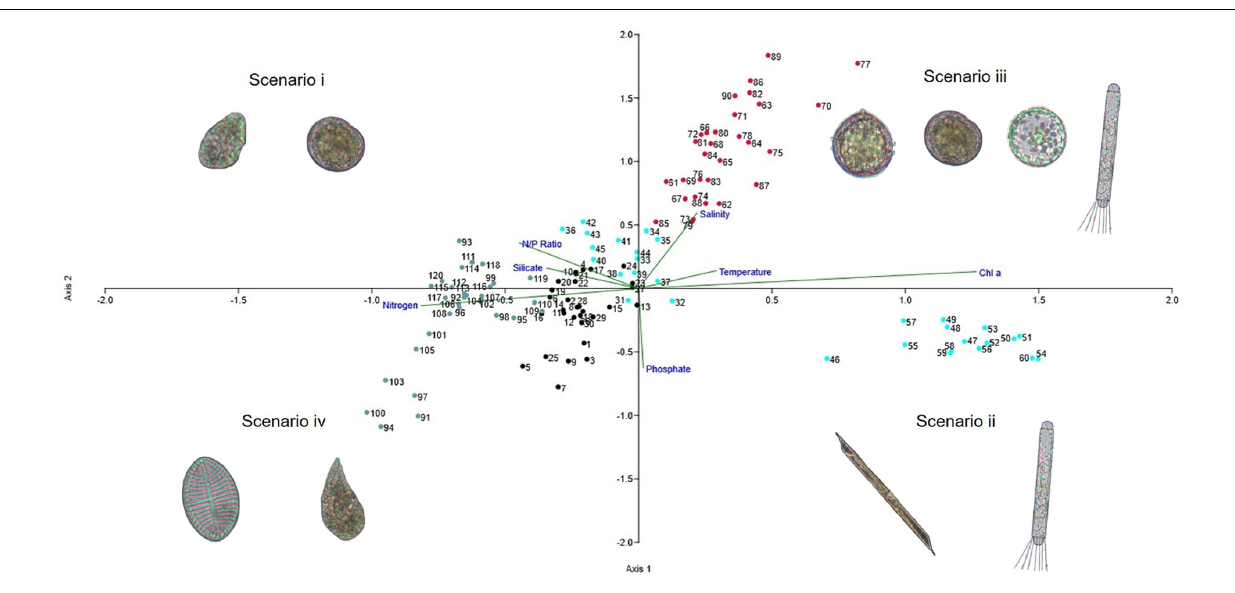
FIGURE 3 | Canonical correlation analysis and abundant species representing the respective scenarios. Numbers and colors denote sampling stations and periods (black – 1 to 30: 2009–2010; blue – 31 to 60: 2010–2011; red – 61 to 90: 2013–2014; gray – 91 to 120: